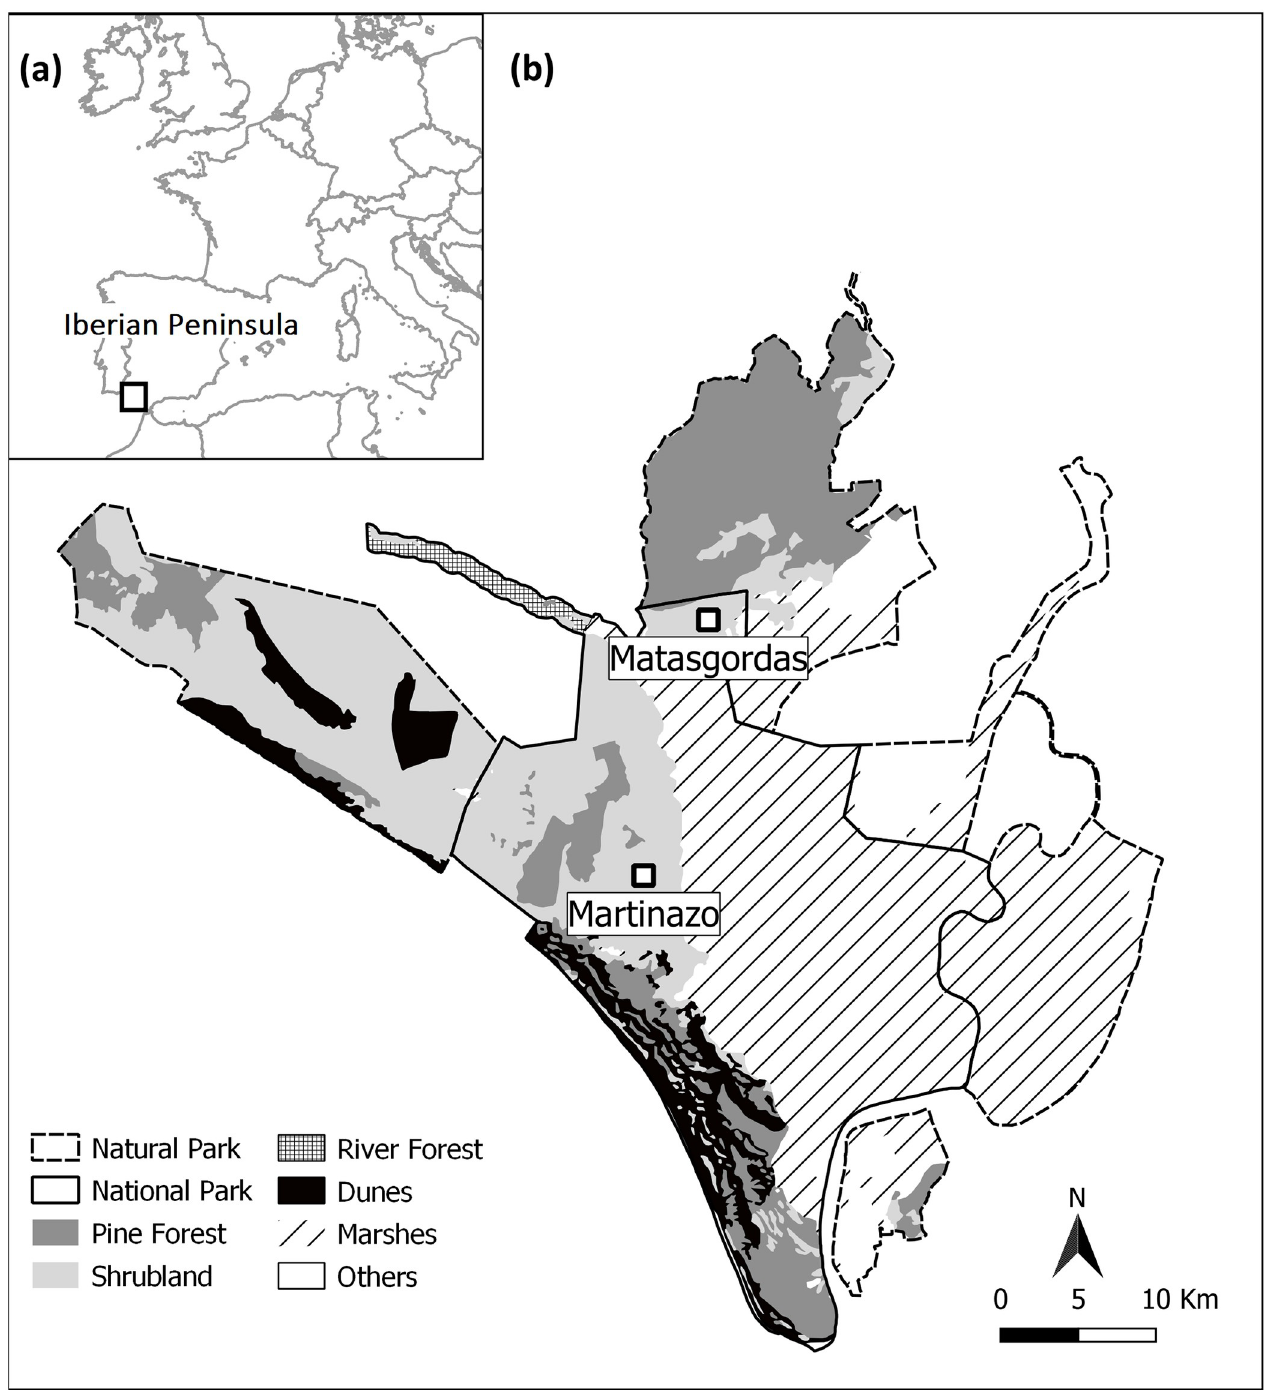
Fig 1. Study area. a) Location of Do ñ ana National Park in Europe and the Iberian Peninsula. b) Location of the study sites: Matasgordas (area = 274 ha) and Martinazo (area = 16.7 ha).